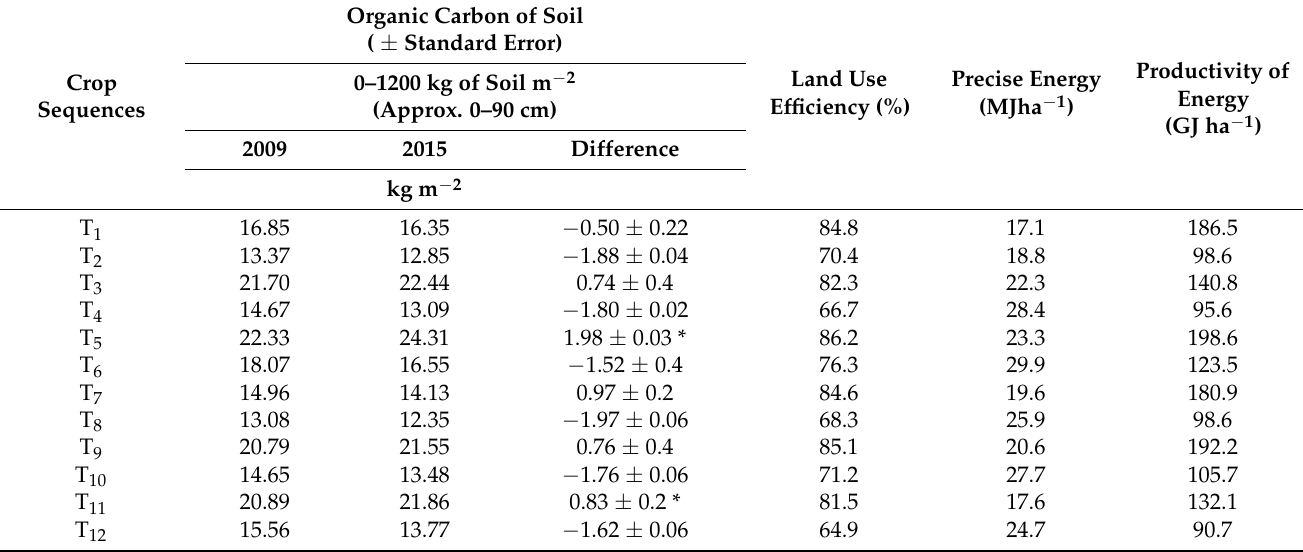
Table 7. Efficiencies of energy use and its dynamics and SOC stocks (0–90 cm) under alternative cropping systems and precision land leveling